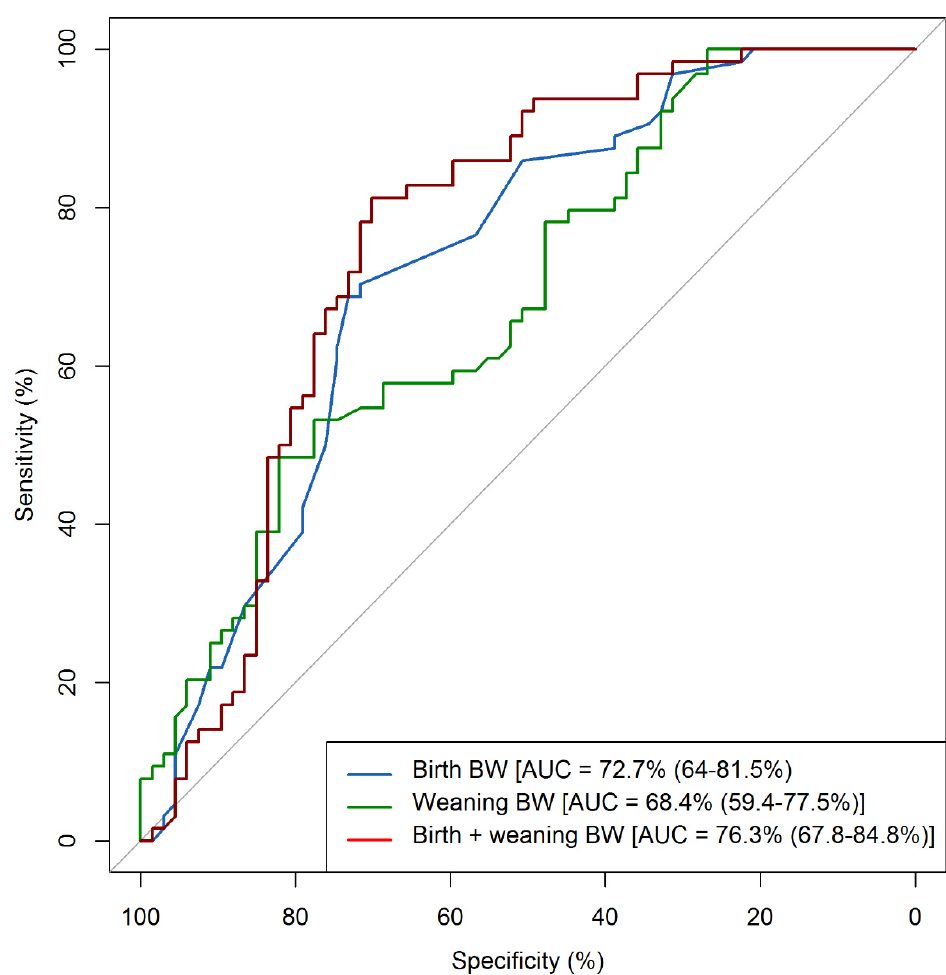
Figure 2. Receiver Operating Characteristic (ROC) curve representing the predictive performance of three di ff erent models for identifying pigs that would reach 110 kg of body weight (BW) at 22 weeks of age. Models included birth BW, weaning BW and birth BW + weaning BW as predictor variables. The ROC curve was estimated using the pROC package [28] of R v3.5.2 [27]. AUC = area under the curve (95% CI); the diagonal line represents an AUC of 0.5.